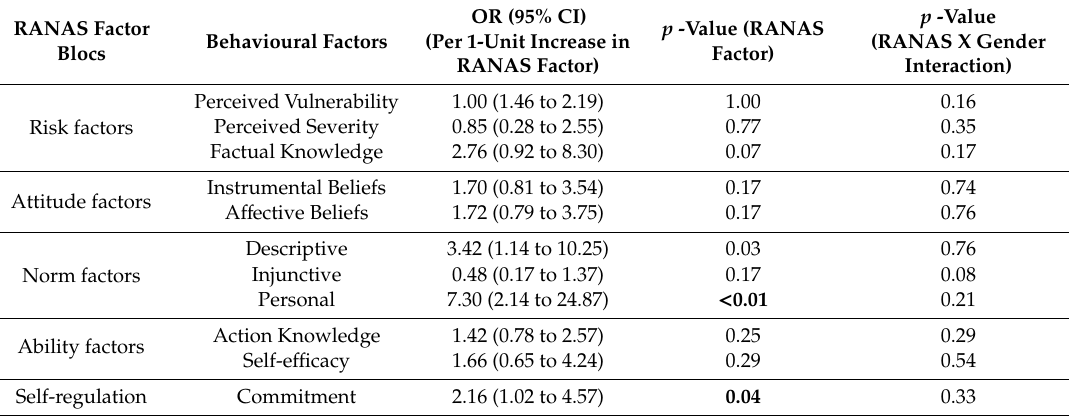
Table 6. Odds ratios (OR) and 95% confidence intervals (CI) derived from binominal logistic regression analyses as indicators of associations between RANAS components and conjectural health behaviours following flooding among people with indirect experience of flooding ( n =